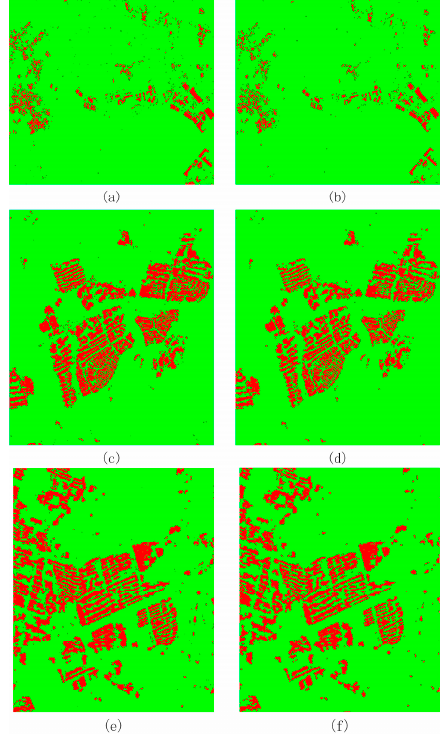
Figure 10. Comparison of results before and after superpixel constraints under three data. ( a , b ) is the experimental result under ESAR data; ( c , d ) is the experimental result under GF-3 data; and ( e , f ) is the experimental result under RADASAT-2 data. ( a , c , e ) are experimental results without superpixel constraints and ( b , d , f ) are experimental results after using superpixel